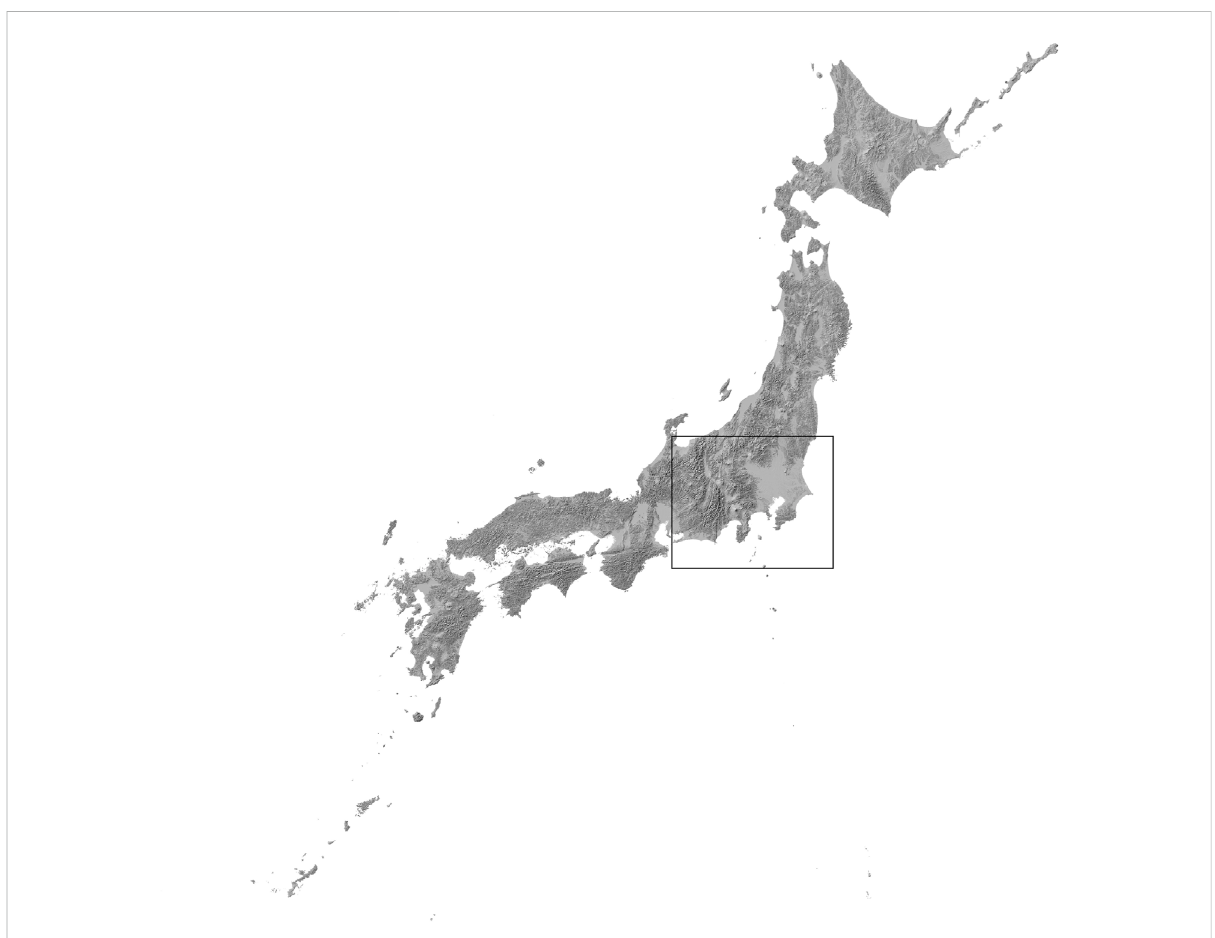
FIGURE 1 Map of this study within the main island of Japan (boxed